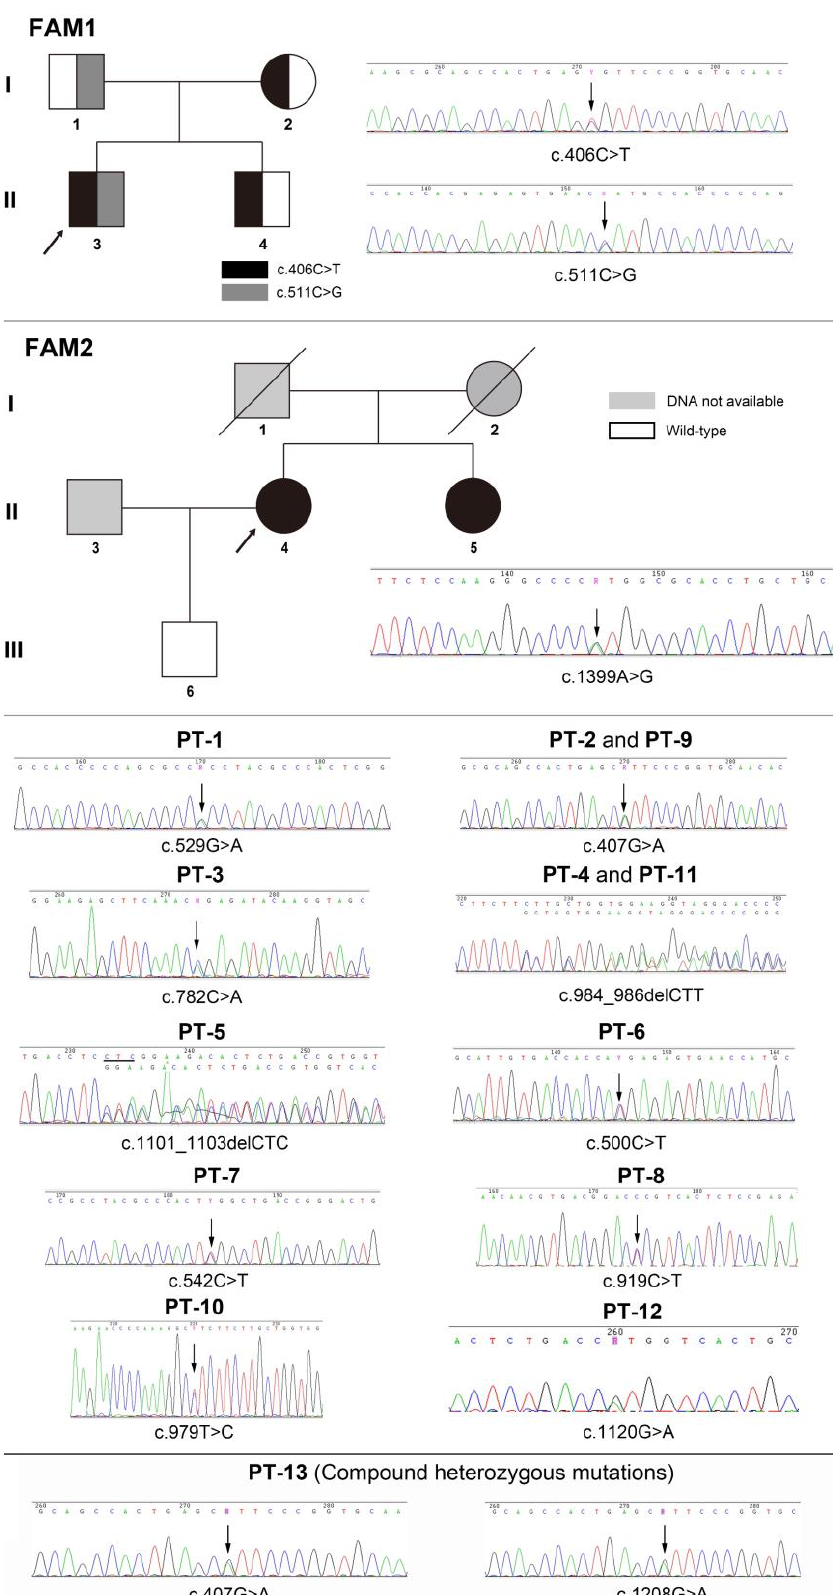
Figure 2. Genetic analysis of ALPL in familial and sporadic patients.